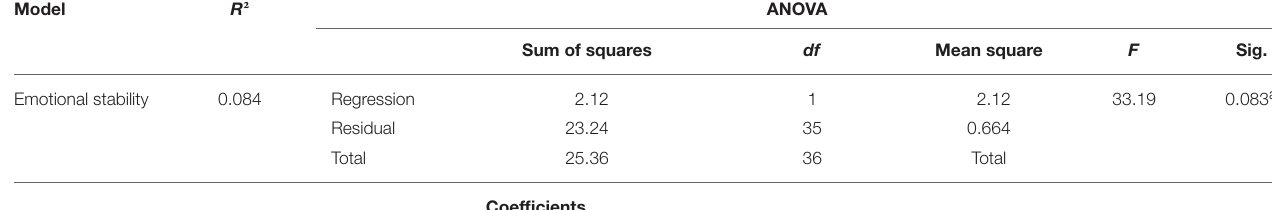
TABLE 2 | Model summary and significance tests of the regression model corresponding to the variable “emotional stability.” Model R ²